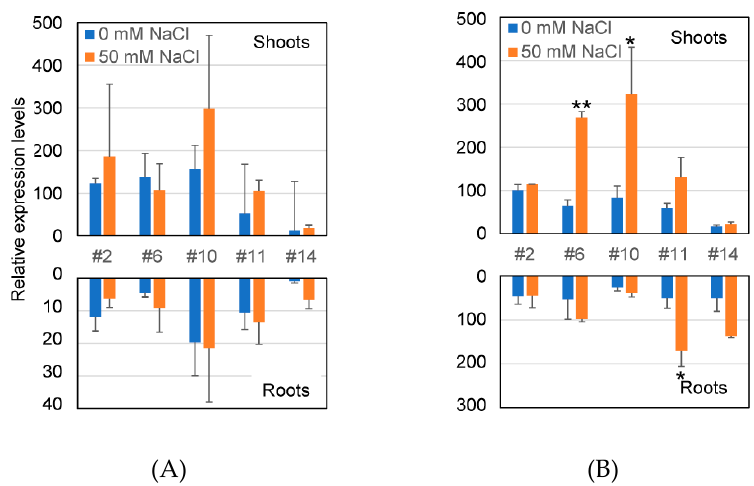
Figure 2. Transcriptional level of GUS gene in transgenic plants. ( A ) Seven-day-old seedlings; ( B ) plants at reproductive stage (four weeks old). RNA was extracted from the shoots and roots of transgenic plants grown on 1/2 MS agar medium, followed by incubation on 50 mM NaCl agar medium for 24 h and used for qRT-PCR. The expression levels of the ubiquitin extension protein were used for normalization of GUS expression. Expression levels are shown relative to that in the roots of Line 14 at the seedling stage under 0 mM NaCl (1.0). Data are presented the mean ± SE ( n = 3, biological replicates). Single and double asterisks denote significant differences compared with values of plants at 0 mM NaCl treatment at p < 0.05 and p < 0.01, respectively, determined using Student’s t -test.